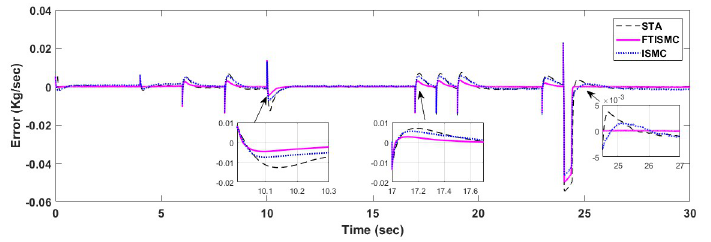
Fig 10. Comparison of error